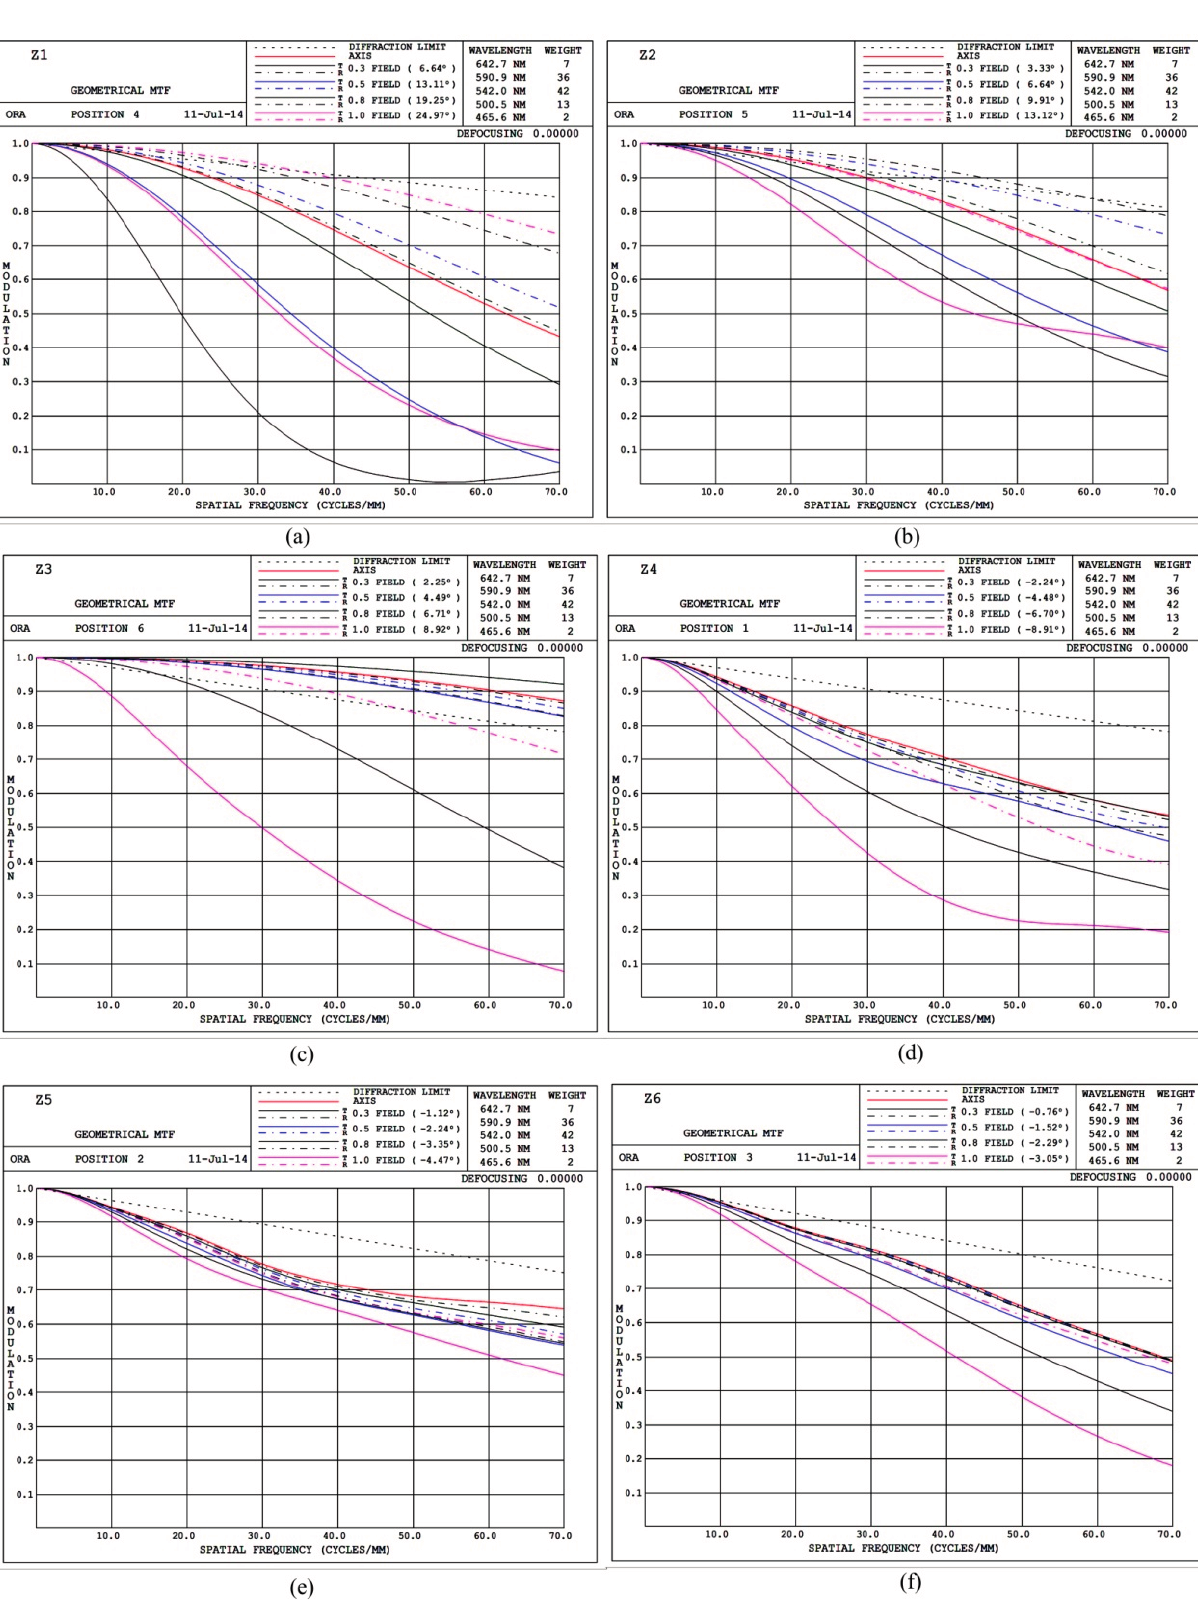
Figure 10. MTFs of the proposed lens: ( a ) Zoom 1; ( b ) Zoom 2; ( c ) Zoom 3; ( d ) Zoom 4; ( e ) Zoom 5; ( f ) Zoom